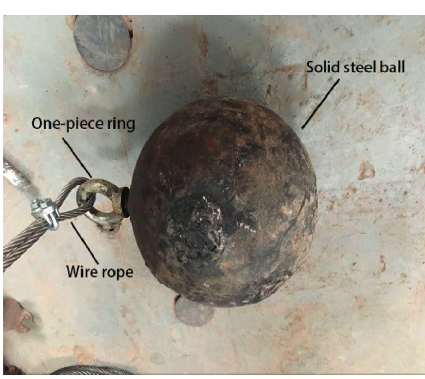
Figure 10: Pendulum